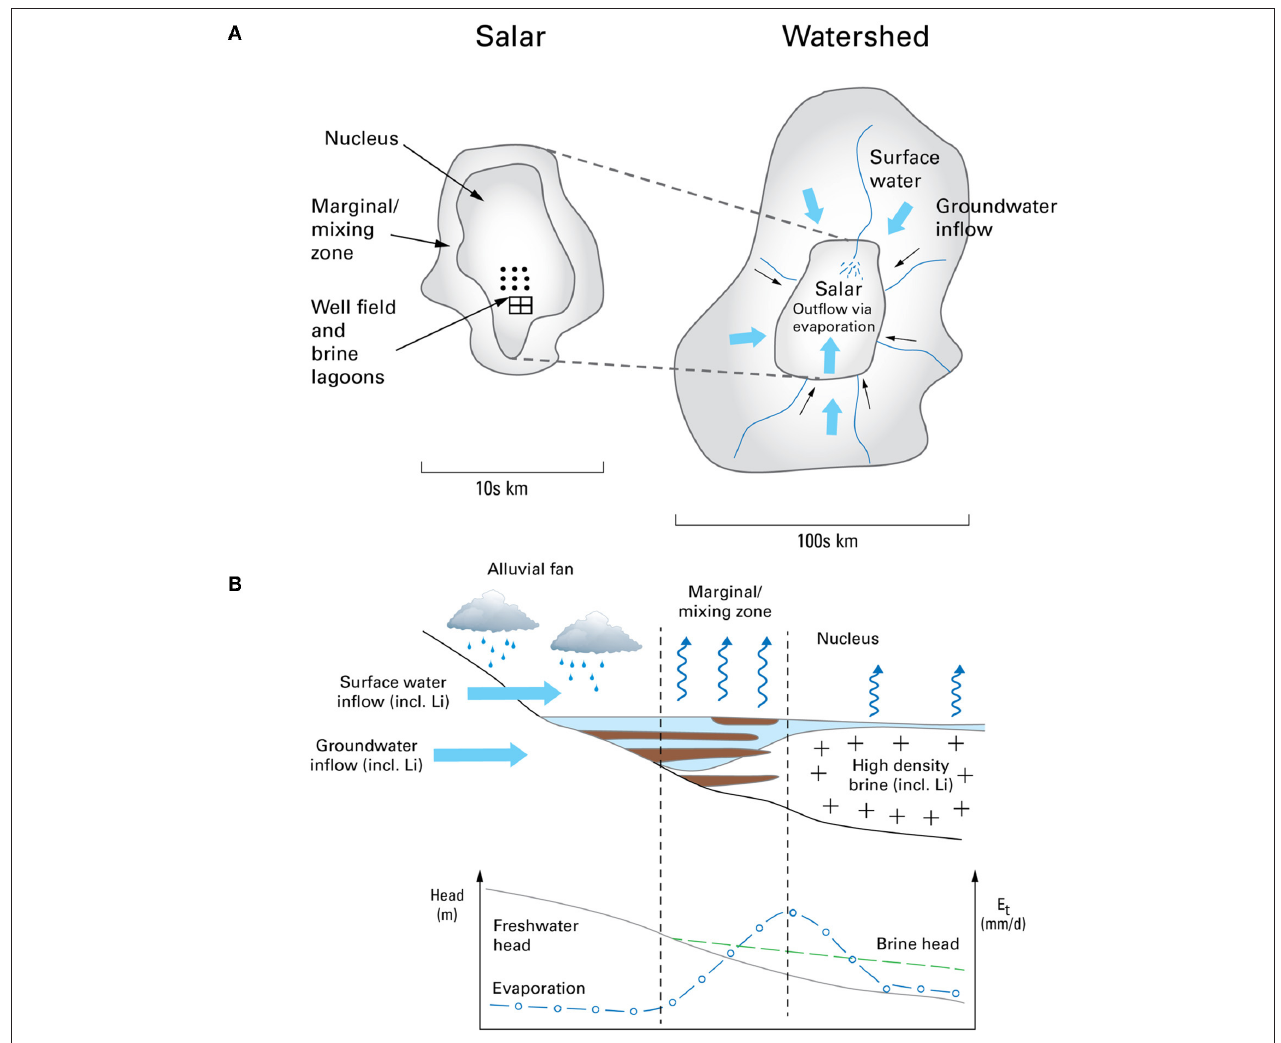
FIGURE 1 | Watershed, salar (A) and nucleus processes for a mature salar (B)